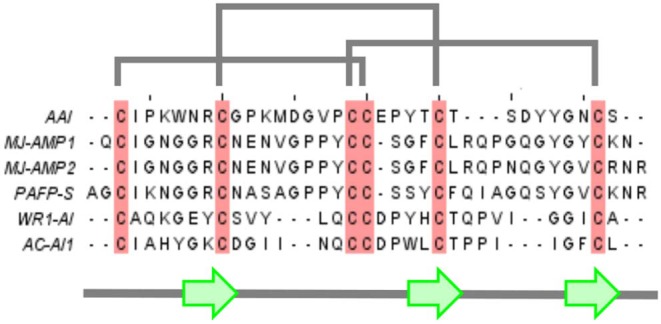
Multiple alignment of AAI with other members of the amylase inhibitor knottin family. Mj-AMP1, Mj-AMP2: Mirabilis jalapa L. seed antimicrobial peptides 1 and 2 (Cammue et al., 1992), PAFP-S: Phytolacca americana seed antifungal peptide (Gao et al., 2001), WR-AI1: Wrightia religiosa cystine knot α-amylase inhibitor (Nguyen et al., 2014), AC-AI1: Allamanda cathartica cystine knot α-amylase inhibitor (Nguyen et al., 2015).